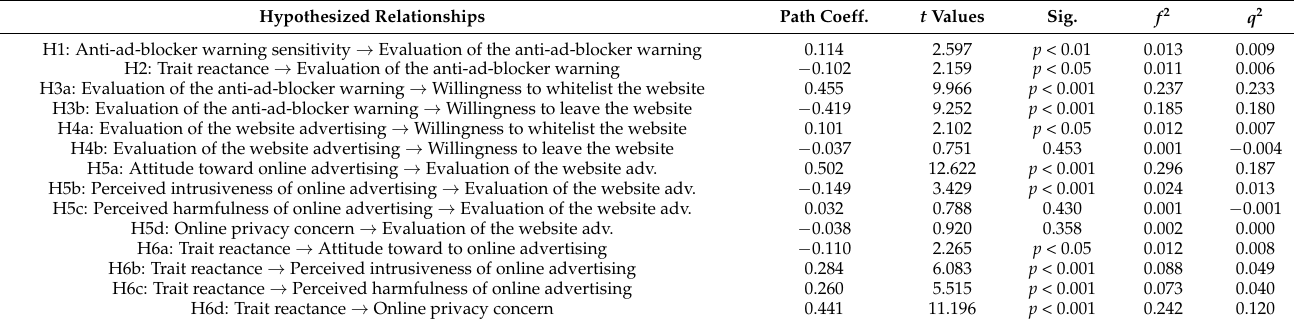
Table 3. Evaluation of the structural model